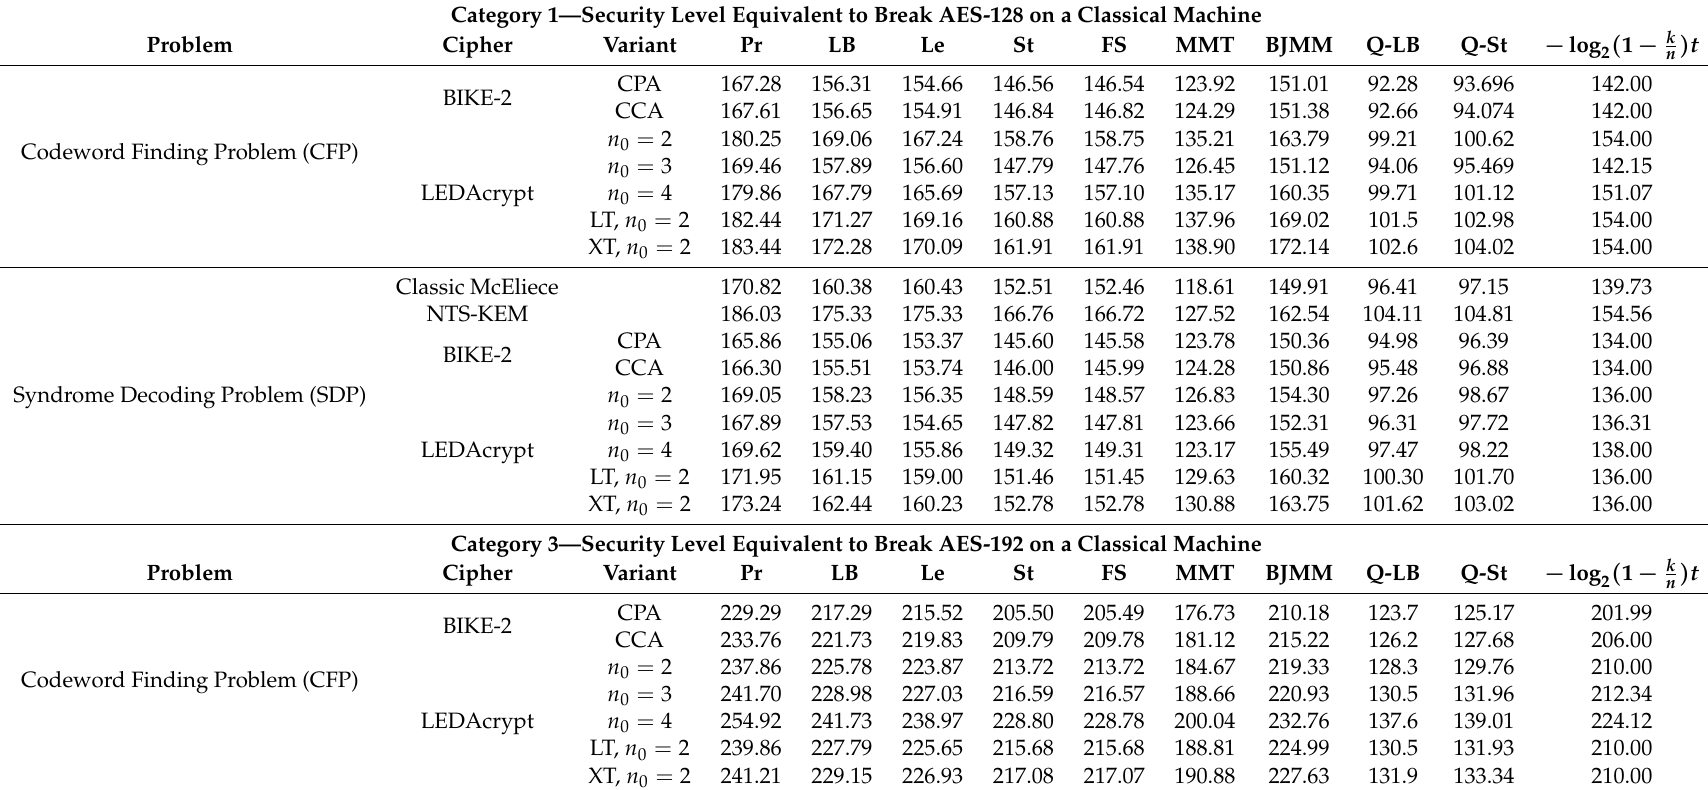
( bit _ operations ) , for each ISDs applied to NIST round-2 code-based cryptosystems. Information Set Decoding (ISD) Table 4. Computational costs expressed as log 2 variants are labeled as: Prange (Pr), Lee and Brickell (LB), Leon (Le), Stern (St), Finiasz and Sendrier (FS), May–Meurer–Thomae (MMT), and Becker–Joux–May–Meurer (BJMM); quantum accelerated variants prefixed by “Q-”. The quantum complexities are expressed in log circuit, and thus provide a lower bound on the actual quantum circuit complexity. The table also reports a simple approximation for the asymptotic cost of classical ( 1 − k ) t , computed for all ISDs, − log 2 n